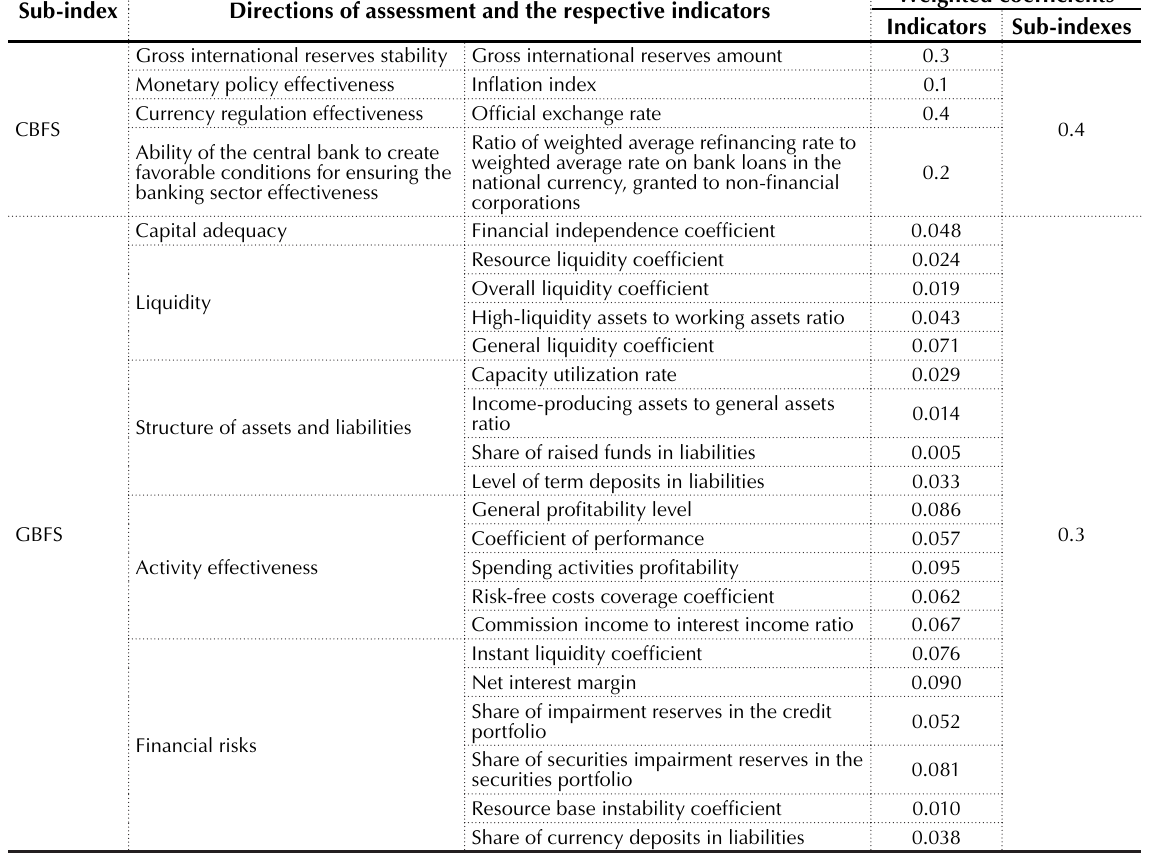
Table 3. Information support of the banking system financial stability integral assessment according to the differential